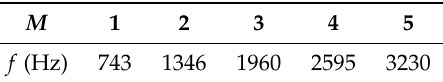
Table 2. Dual-band decode crossover frequencies producing 20% integrated D-error for Ambisonic orders 1 to 5, according to